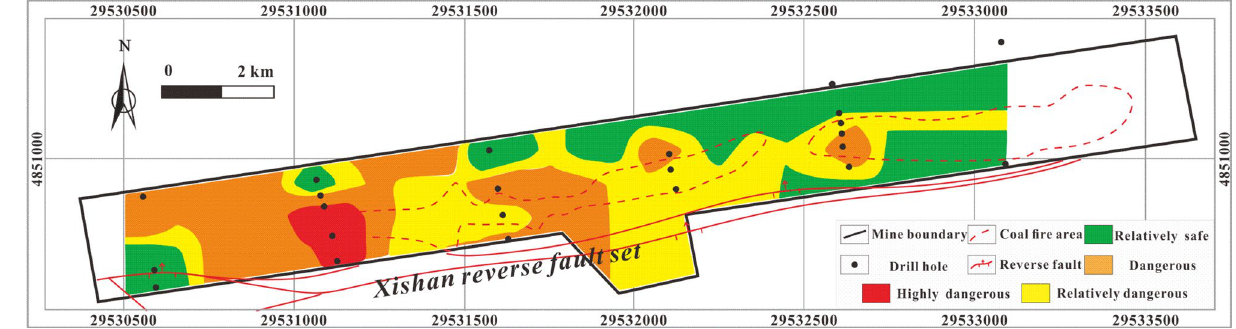
Figure 11. Thematic map of CO 2 concentration in MAPGIS software.